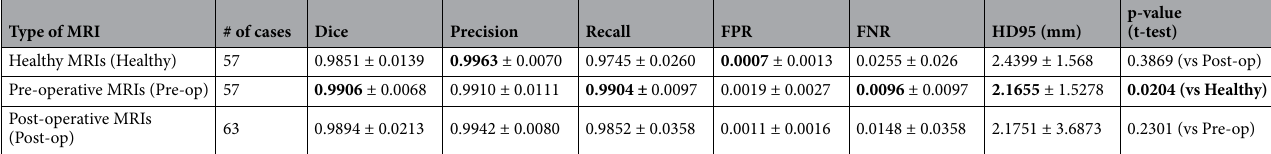
Table 3. Performance comparison of skull stripping for different stage MRIs of UPMC data. The best result is highlighted in bold.